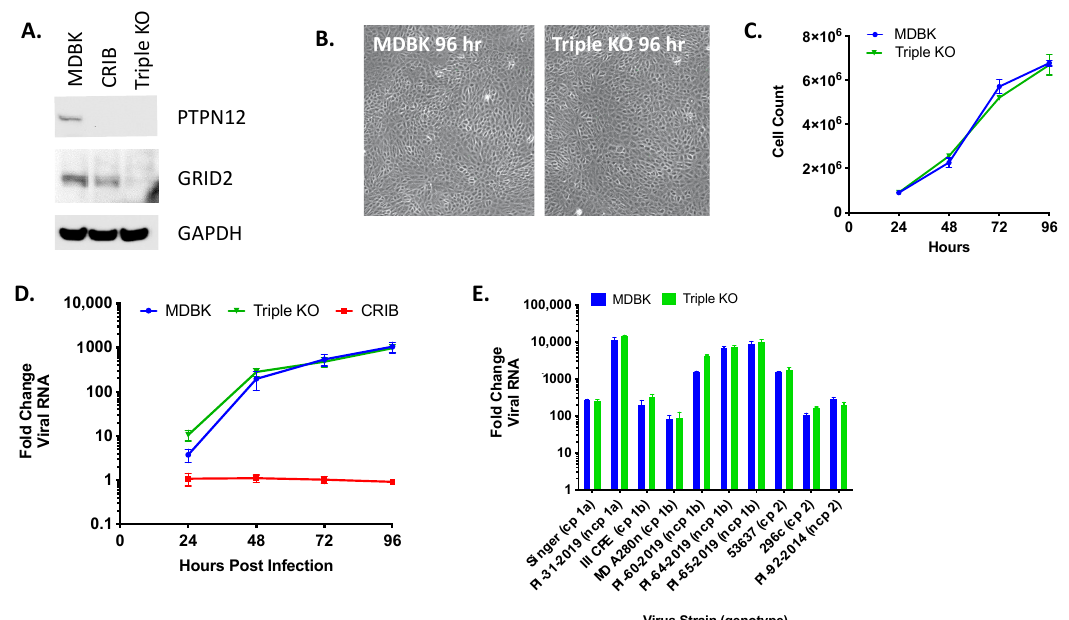
Figure 5. Triple KO of PTPN12 , GRID2 , and RABGAP1L genes does not impact BVDV infection in MDBK cells. Panel ( A ) western blot of SDS-PAGE for PTPN12, GRID2, and GAPDH (loading control). Panel ( B ) MDBK and MDBK-TKO cell morphology (10x). Panel ( C ) Cell growth in T-25 flasks. Panel ( D ) Multistep virus growth curve. Cells were infected with BVDV strain NADL (MOI 0.01). Cells were collected and processed 0–96 h post-infection for quantitation of viral RNA using RT-qPCR. Results represent the mean ± standard deviation ( n = 3). Panel ( E ) Cells were infected with various cytopathic (cp) and non-cytopathic (ncp) BVDV isolates (MOI = 0.01) and collected at 0 and 96 h post-infection for quantitation of viral RNA using RT-qPCR. Results represent means at 96 h ± standard deviation ( n = 3).